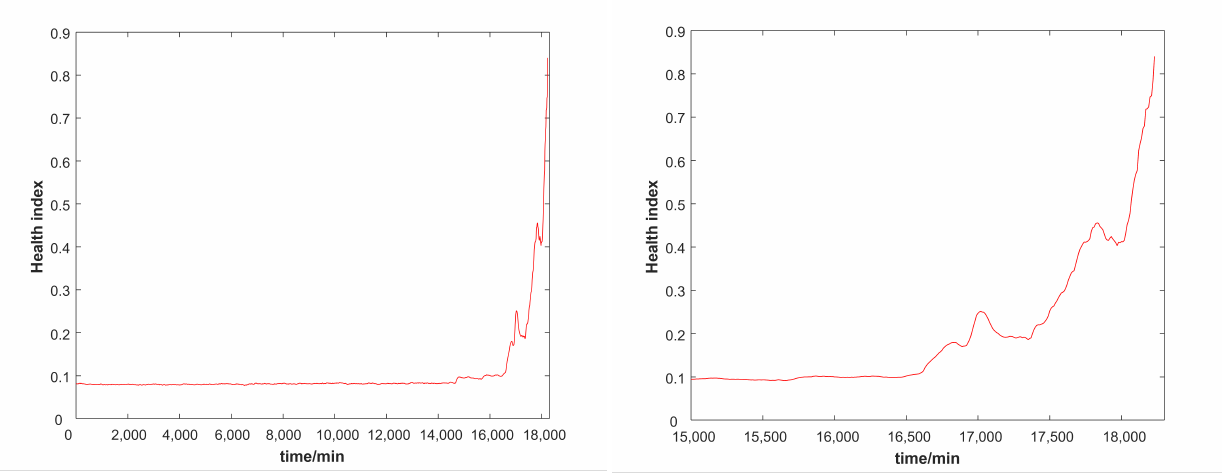
Figure 7. The health indices constructed by the SAE, where the right subgraph is a zoomed graph of the left subfigure in the range of 15,000 ∼ 18,000 min.